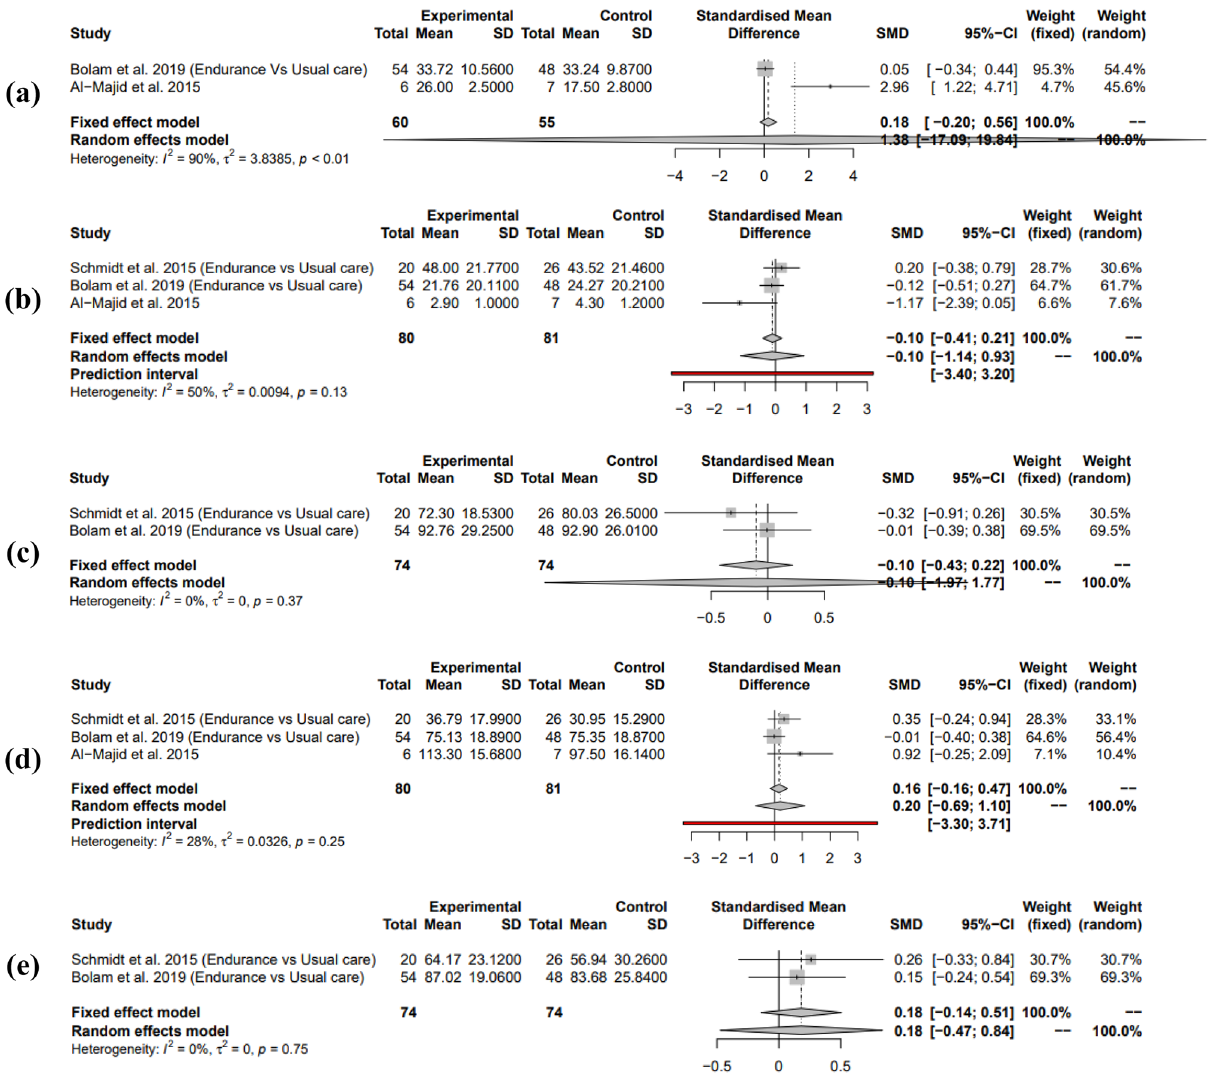
Figure 7. Random effects models showing the impact of endurance interventions on ( a ) cardiorespiratory fitness, ( b ) global fatigue, ( d ) QOL during adjuvant treatment. Fixed effects models showing the impact of endurance interventions on ( c ) muscular strength, ( e ) social functioning. Positive effect sizes favour the exercise intervention in ( a , c , d,e ). Negative effect sizes favour the exercise intervention in ( b